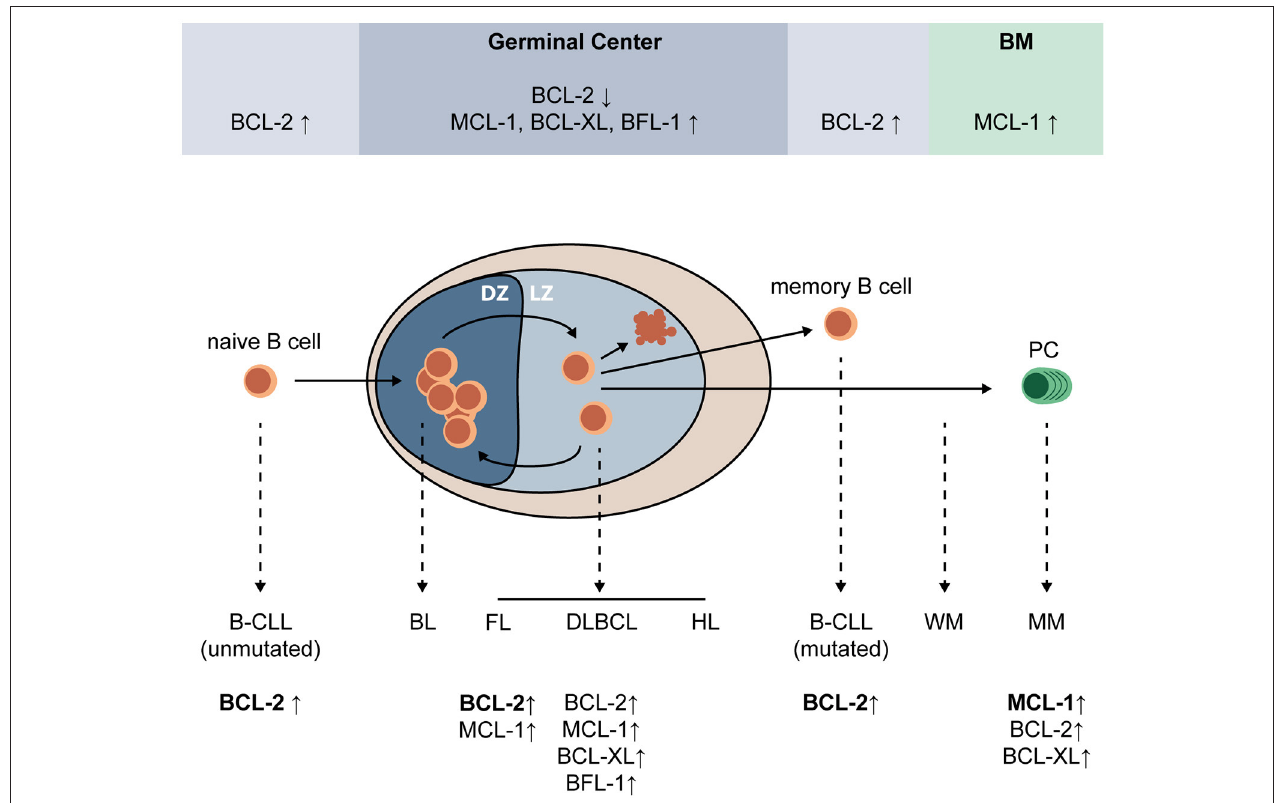
FIGURE 1 | Expression of pro-survival BCL-2 family proteins during PC differentiation and after malignant transformation of (post-) GC B-cells. Upon encounter of a naïve B-cell with its cognate antigen, and in the presence of adequate T cell help, a germinal center (GC) is formed where the B-cell undergoes multiple cycles of expansion and hypermutation in the dark zone (DZ), and affinity-based selection in the light zone (LZ). Low-affinity B-cells undergo apoptosis, while high-affinity B-cells can undergo further selection, or exit the GC as a memory B-cell or plasma cell (PC). In the GC, BCL-2 expression is strongly repressed and expression of MCL-1, BCL-XL, and BFL-1 is increased. MCL-1, but not BCL-XL, was shown to be essential for survival of GC B-cells. Naïve and memory B-cells have high expression of BCL-2 and are sensitive to its inhibition, and PC depend on MCL-1 expression for survival. Erroneous targeting of activation-induced cytidine deaminase (AID) during somatic hypermutation and class switch recombination can lead to mutations that promote malignant transformation, resulting in a variety of GC-derived malignancies (dashed lines). Multiple GC-derived malignancies, such as follicular lymphoma (FL), diffuse-large B-cell lymphoma (DLBCL), some B-cell chronic lymphocytic leukemias (B-CLL), and multiple myeloma (MM) depend on overexpression of BCL-2 family proteins for survival. BL, Burkitt’s lymphoma; BM, bone marrow; CLL, chronic lymphocytic leukemia; DLBCL, diffuse-large cell B-cell lymphoma; DZ, dark zone; FL, follicular lymphoma; HL, Hodgkin lymphoma; LZ, light zone; MCL, mantle cell lymphoma; MM, multiple myeloma; PC, plasma cell; WM, Waldenström